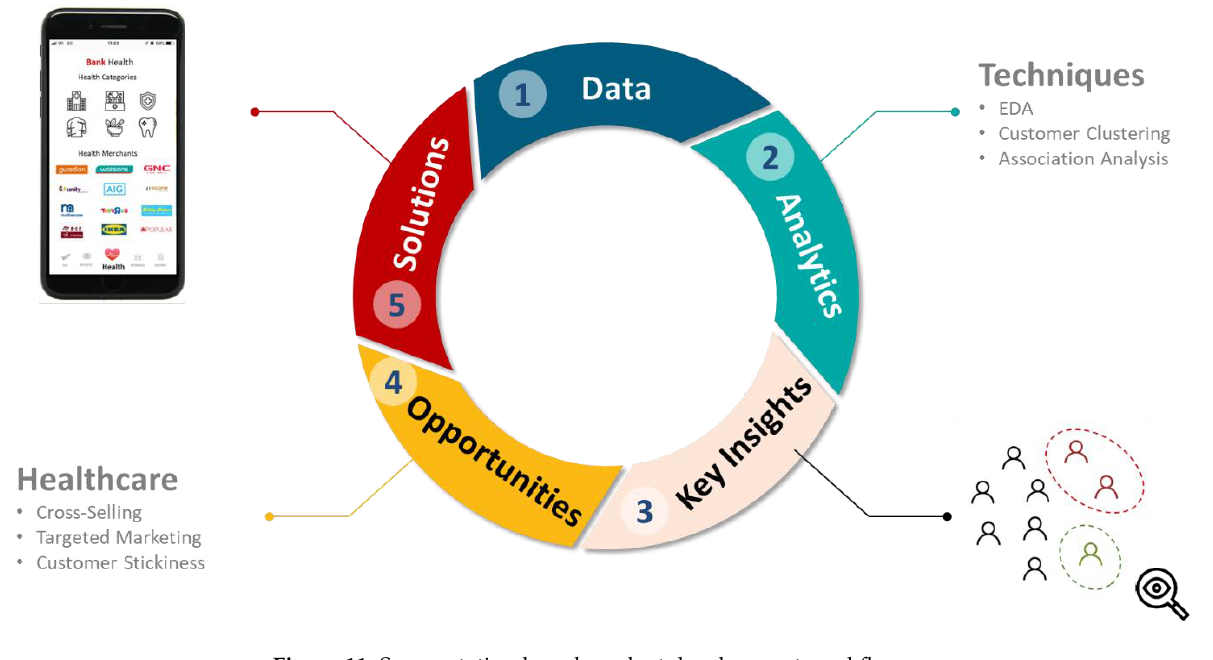
Figure 11. Segmentation-based product development workflow.